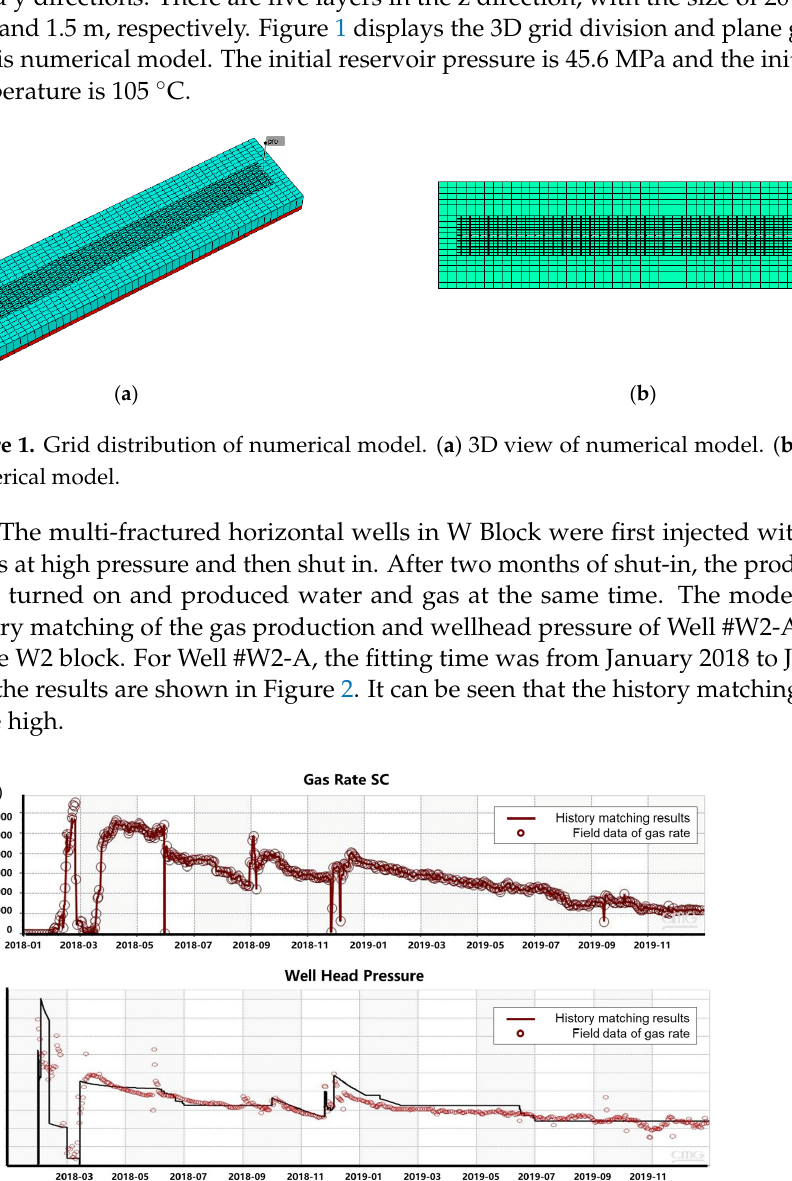
Figure 3. History matching results of ( a ) gas production and ( b ) wellhead pressure of Well #W2-B. 3. Multi-Well Pressure Interference Analysis in W Shale Gas Reservoir 3.1. Numerical Modeling The numerical model with a multi-fractured horizontal well in a shale gas reservoir is established using the numerical simulation software CMG (model dimension: 907.2 m × 2250 m × 36.5 m). The grid dimensions are 30 × 30.24 m and 45 × 50 m in the x and y directions. There are 5 layers in the z direction, with the size of 20 m, 6 m, 4 m, 5 m, and 1.5 m, respectively. Figure 4 displays the 3D grid mesh division of this numerical model. The basic parameters of W Block are shown in Table 1.